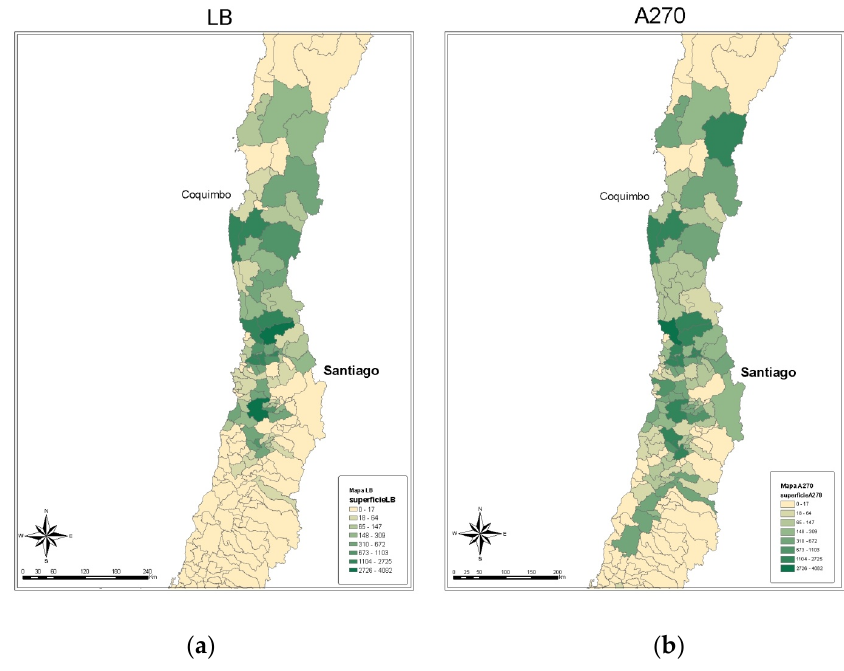
Figure 3. Hectares under avocado at baseline ( a ) and in severe change scenarios in 2070 ( b ).